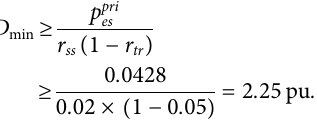
Figure 4 for the placement of each fi lter element. It is worth mentioning that R c yields an over-damped characteristic at the fi lter ’ s resonance frequency, which is f res (cid:2) 1 . 80 kHz or 0.334 times f sw .